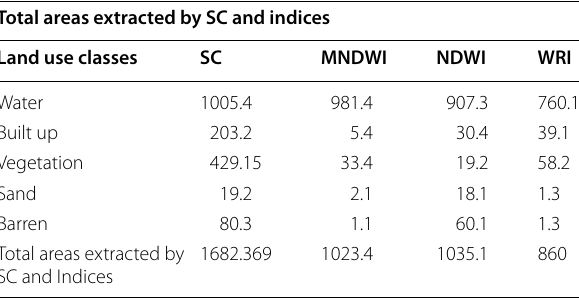
Table 5 Total flooded area extracted from different techniques Total areas extracted by SC and indices Land use classes